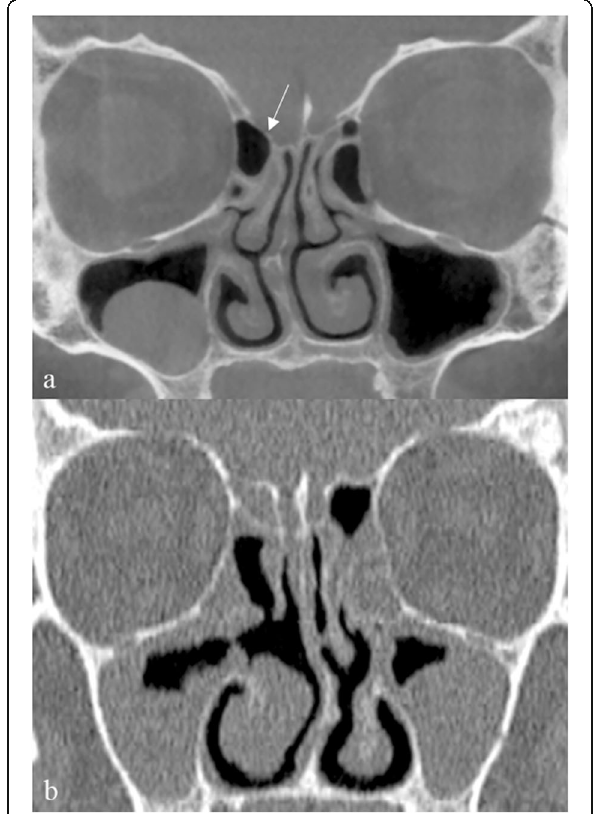
Fig. 5 Anatomic variants of the ethmoid roof. CBCT ( a ) shows clear asymmetry, the slope of the right vertical lamella (arrow) being more pronounced than on the contralateral side. b MDCT shows a deep olfactory fossa (type III according to the Keros